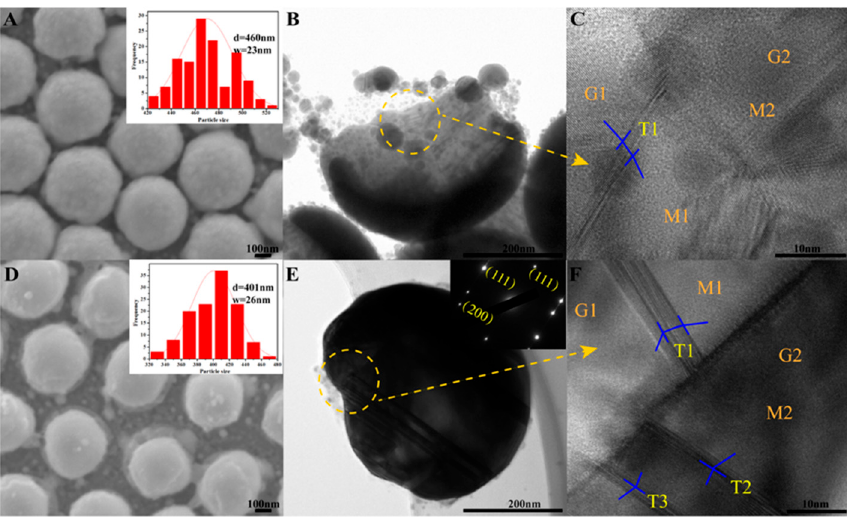
Figure 2. ( A ) SEM, ( B ) TEM and ( C ) HRTEM images of SiO 2 /Ag/SiO 2 nanocap arrays annealed at 400 °C and ( D – F ) 800 °C. The inserts are the fast Fourier transform (FFT) of the Ag nanotwins; T, G, and M are the abbreviations for twin, grain, and matrix.